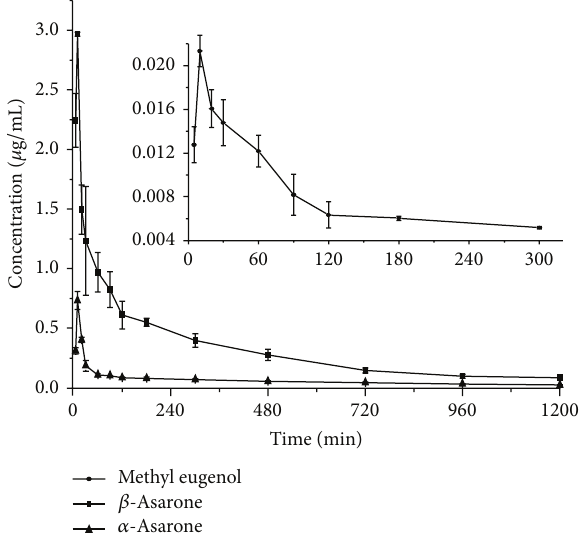
Figure2:Themeanplasmaconcentration-timeprofileofanalytesin rats after oral administration volatile oil of Acorus tatarinowii Schott (0.2